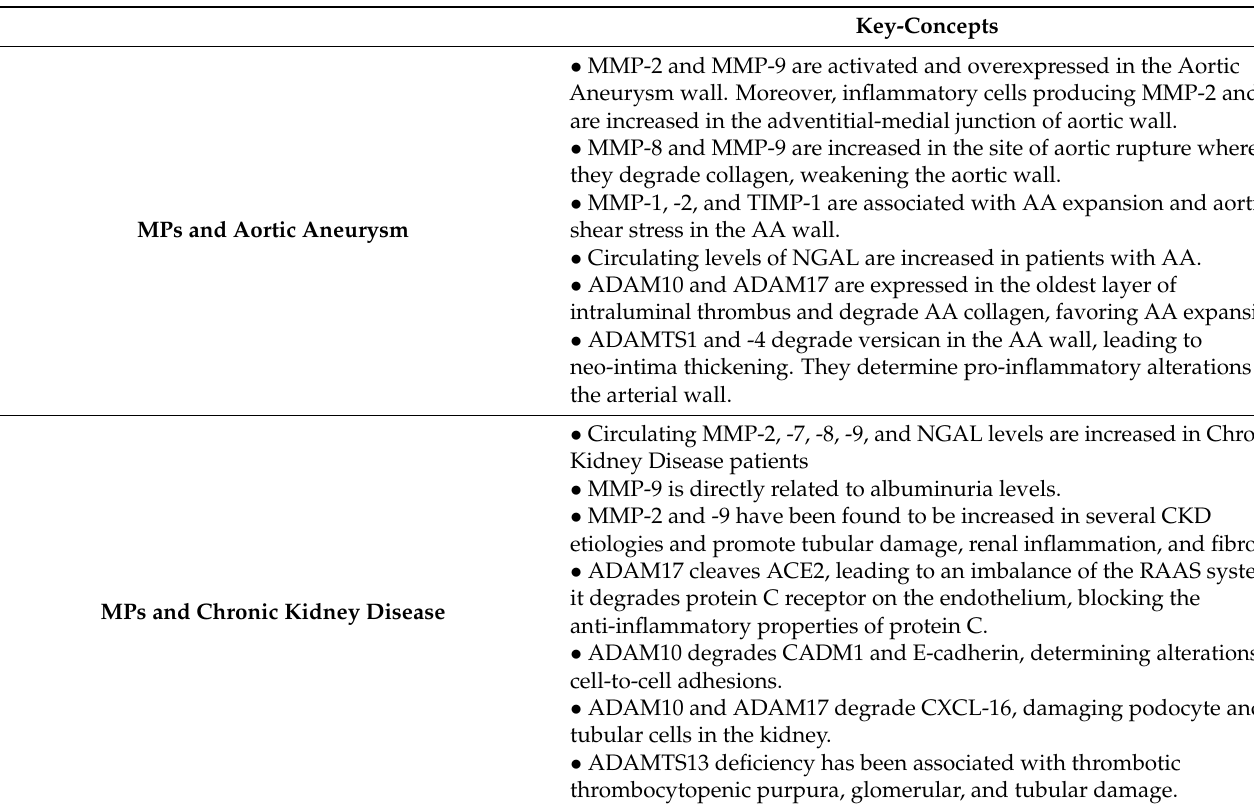
Table 1. Summary of the association between metalloproteinases (MPs), chronic kidney disease, and aortic